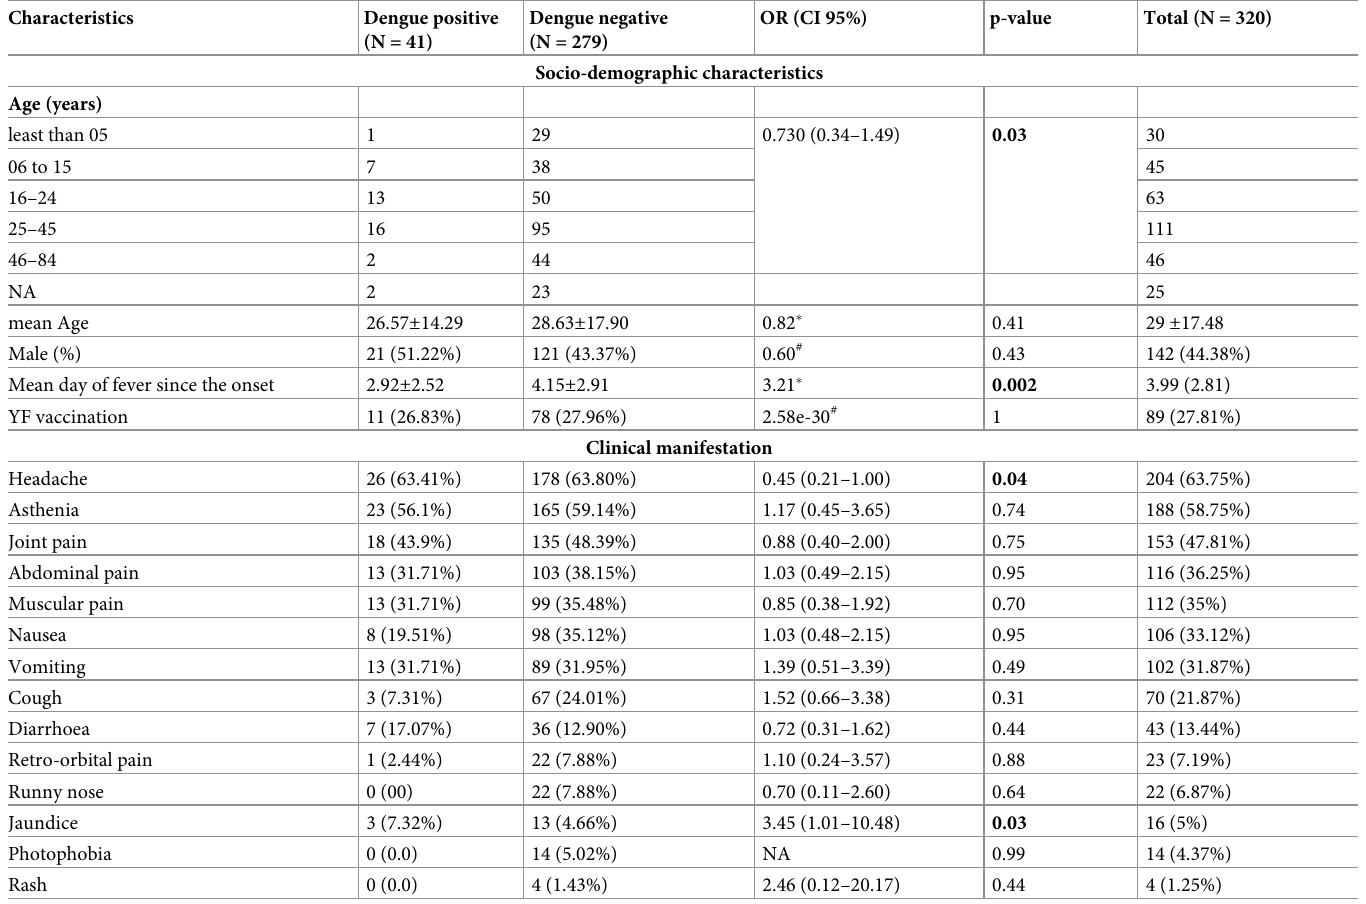
Table 2. General description of the dengue positive and negative cases found in the study.